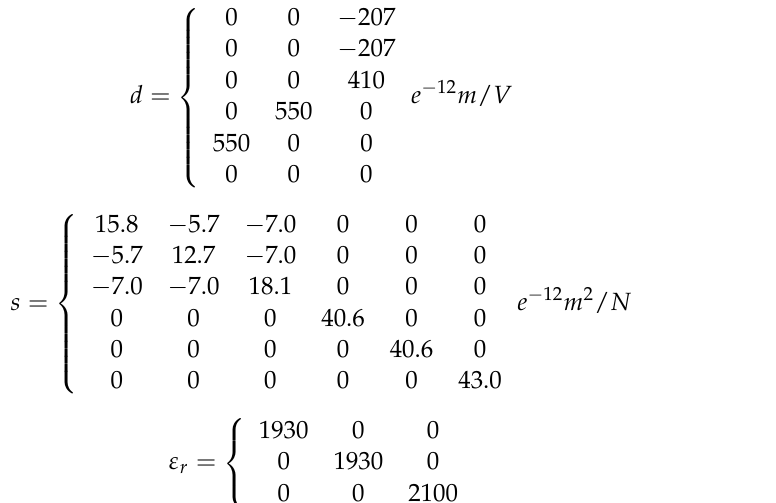
Figure 1. Schematic diagram of piezoelectric energy harvesters. ( a ) The traditional structure of a PEH with stainless steel substrate. ( b ) The proposed hollow structure of a PEH with brass substrate. ( c ) Components of a traditional PEH. ( d ) Components of the proposed PEH.